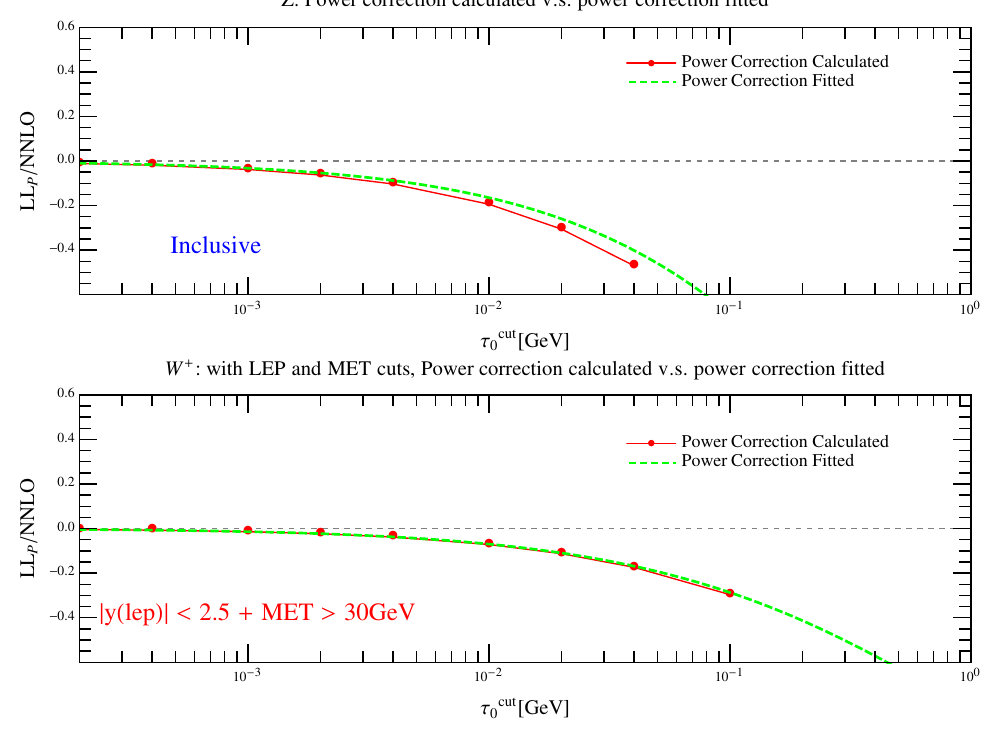
Figure 1 . A comparison of the (cid:12)tted power corrections with the LL P calculated in this paper for inclusive Z -boson production (upper panel) and W + -boson production with the indicated cuts on the (cid:12)nal-state leptons (lower panel). We have normalized the O ( (cid:11) 2 known O ( (cid:11) 2 ) s